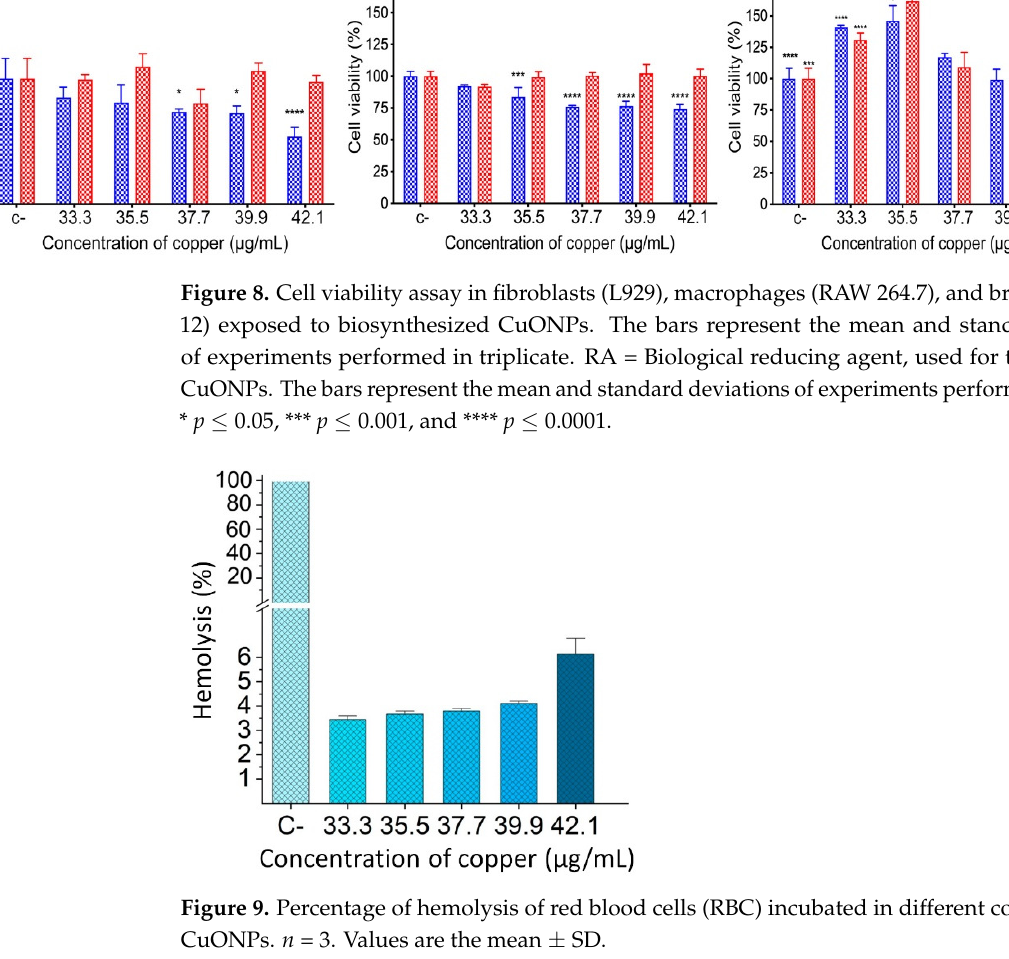
Figure 8. Cell viability assay in fibroblasts (L929), macrophages (RAW 264.7), and breast cells (MCF ‐ 12) exposed to biosynthesized CuONPs. The bars represent the mean and standard deviations of experiments performed in triplicate. RA = Biological reducing agent, used for the synthesis of CuONPs. * p ≤ 0.05, *** p ≤ 0.001, and **** p ≤ 0.0001.